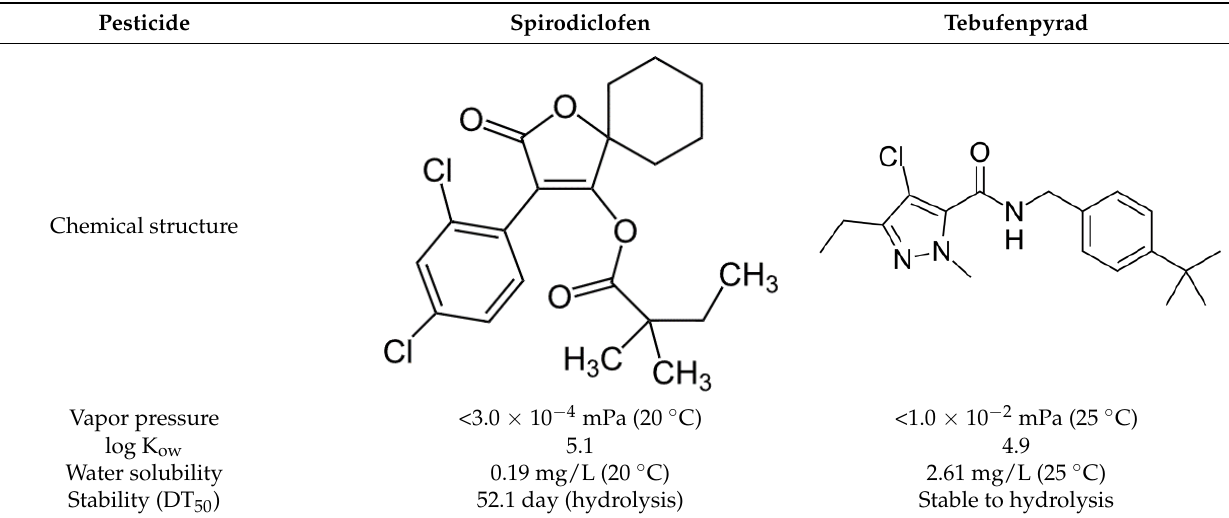
Table A1. Chemical Properties of Spirodiclofen and Tebufenpyrad [7].